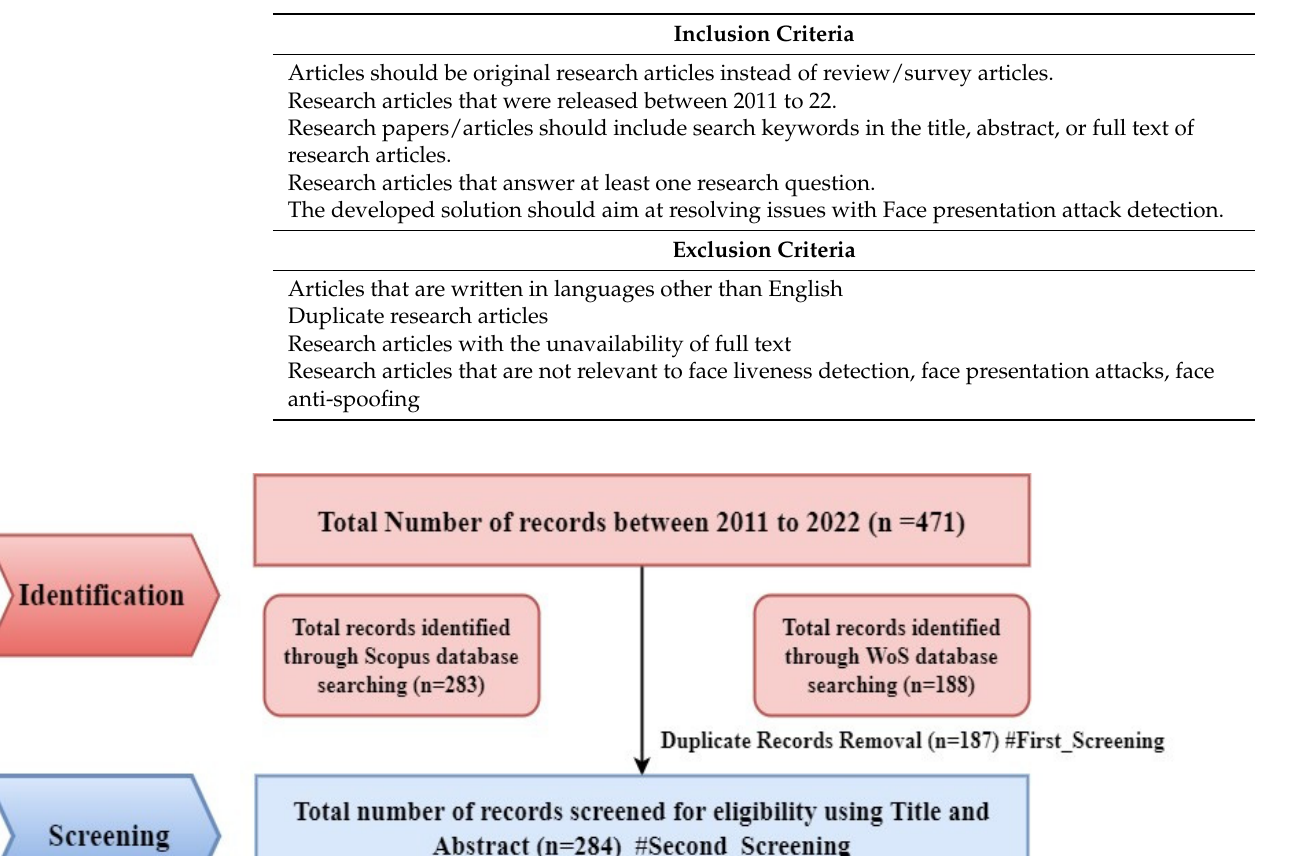
Table 6. Summary of inclusion and exclusion criteria.